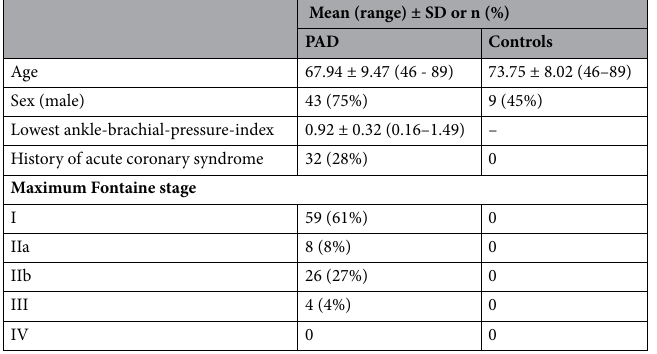
Table 1. Characteristics of the dataset including age, sex, maximum Fontaine stage and lowest ankle-brachial-